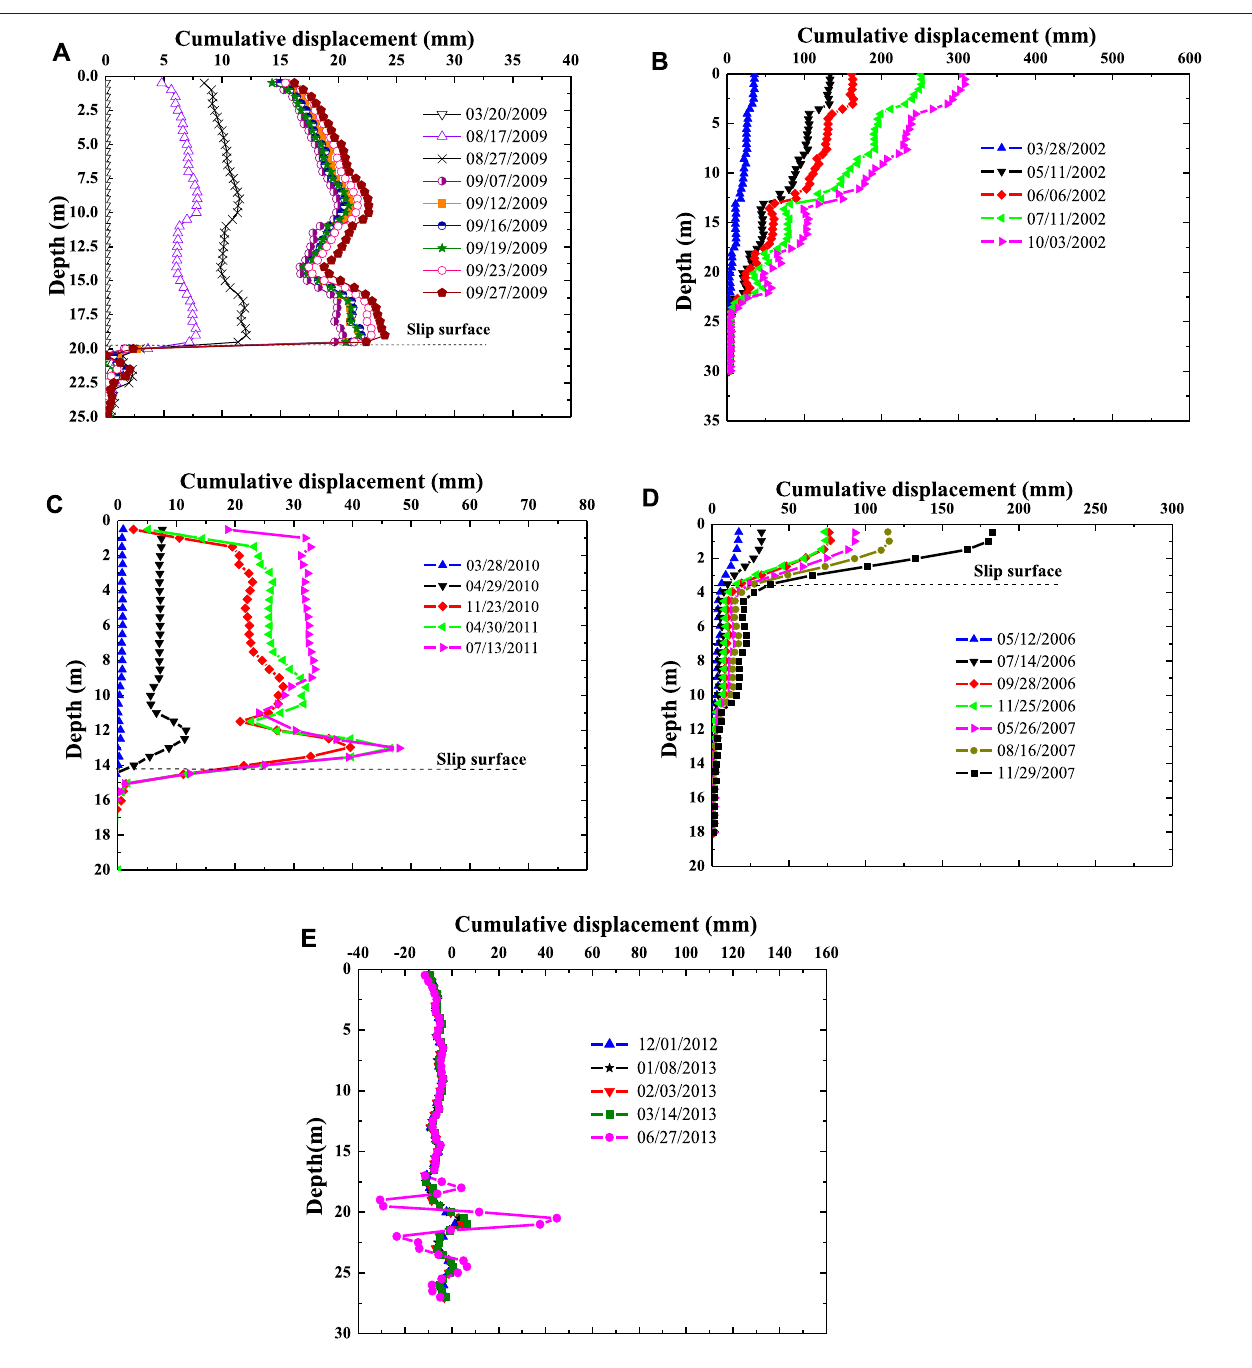
FIGURE 2 | Cumulative displacement against depth pro fi les at different times characterized by. (A) “ D ” shape, (B) “ V ” shape, (C) “ B ” shape, (D) “ r ” shape, and (E) pendulum obtained from the landslides located in Guangdong-Wuzhou, Beijing-Zhuhai, Guangzhou-Heyuan, Beijing-Zhuhai, Manhao-Jinping Highway, China,